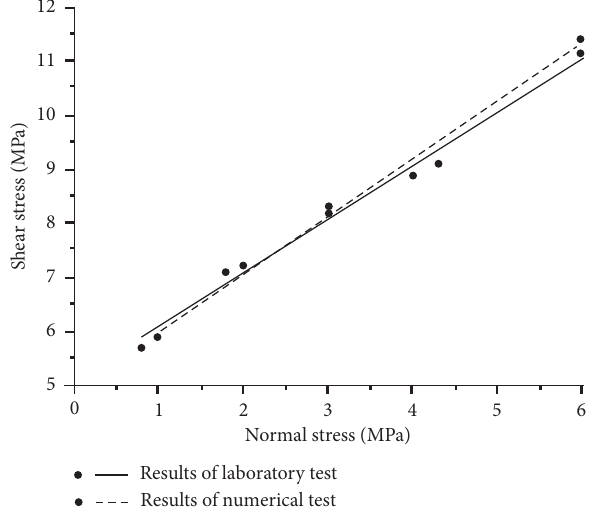
Figure 3: Shear stress-normal stress curve of sample.